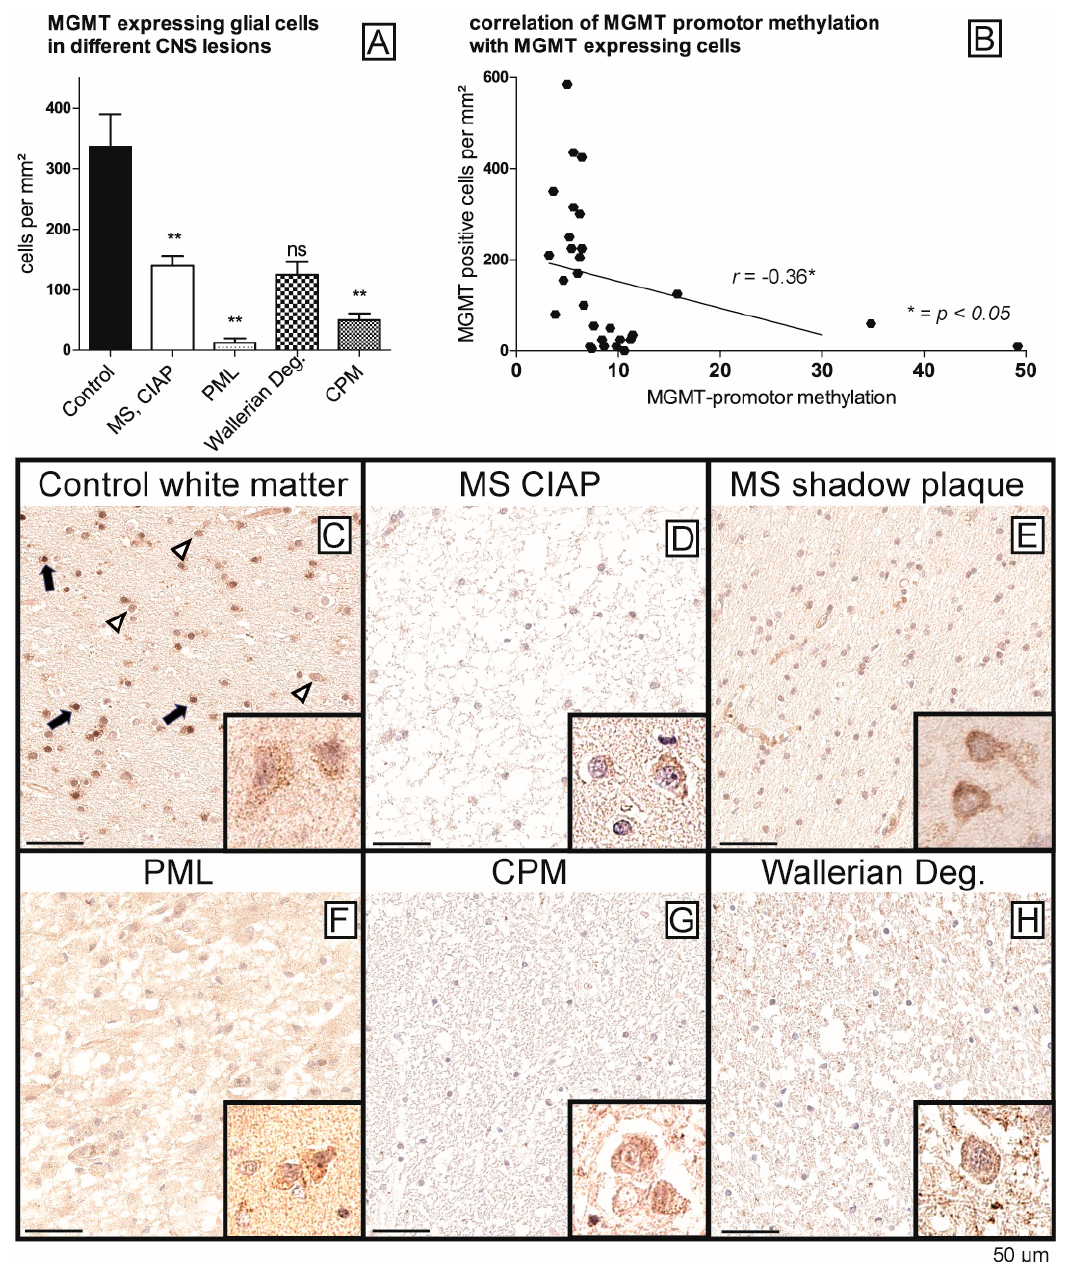
Figure 2. Reduction in MGMT protein expression in samples with enhanced MGMT promoter methylation. Compared to controls, all samples with enhanced MGMT promoter methylation show a reduction in MGMT protein expression in glial cells (** p < 0.01) ( A ). MGMT promoter methylation is negatively correlated with protein expression ( B ), Pearson, r = − 0.36, p < 0.05). Immunohistochemistry of MGMT in white matter of controls ( C ) shows preserved MGMT expression in glial cells (astrocytes (arrowheads) and oligodendrocytes (arrows)), with MGMT staining appearing slightly stronger in oligodendrocytes (morphologically the slightly smaller cells with roundish nuclei). In all other conditions with increased MGMT promoter methylation, such as MS ( D , E ); PML ( F ); CPM ( G ), and Wallerian degeneration ( H ), reduced MGMT staining was detected in all white matter glial cells. The degree of methylation of the lesions did not play a role in the MS samples ( D ), chronic inactive plaque; ( E ), remyelinated plaque-shadow plaque). In all samples, the neurons in the same sections with a similar positive staining of MGMT served as an internal positive control to exclude staining artifacts (inset in ( C – H ) and Supplementary Figure S4, edge length 15 µ m each). Scale bar = 50 µ